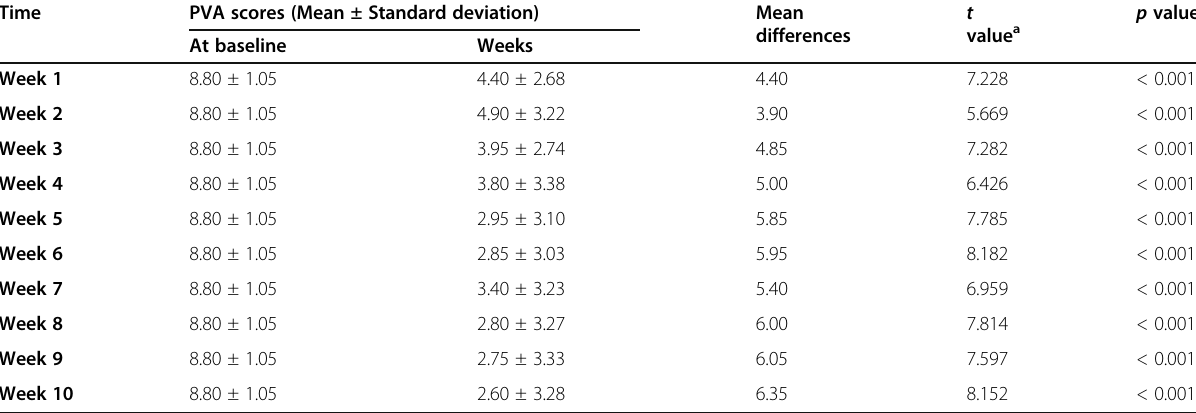
Table 3 The mean comparison of pain levels (post visual analogue scale scores) in females across 10 weeks compared with the baseline (after the